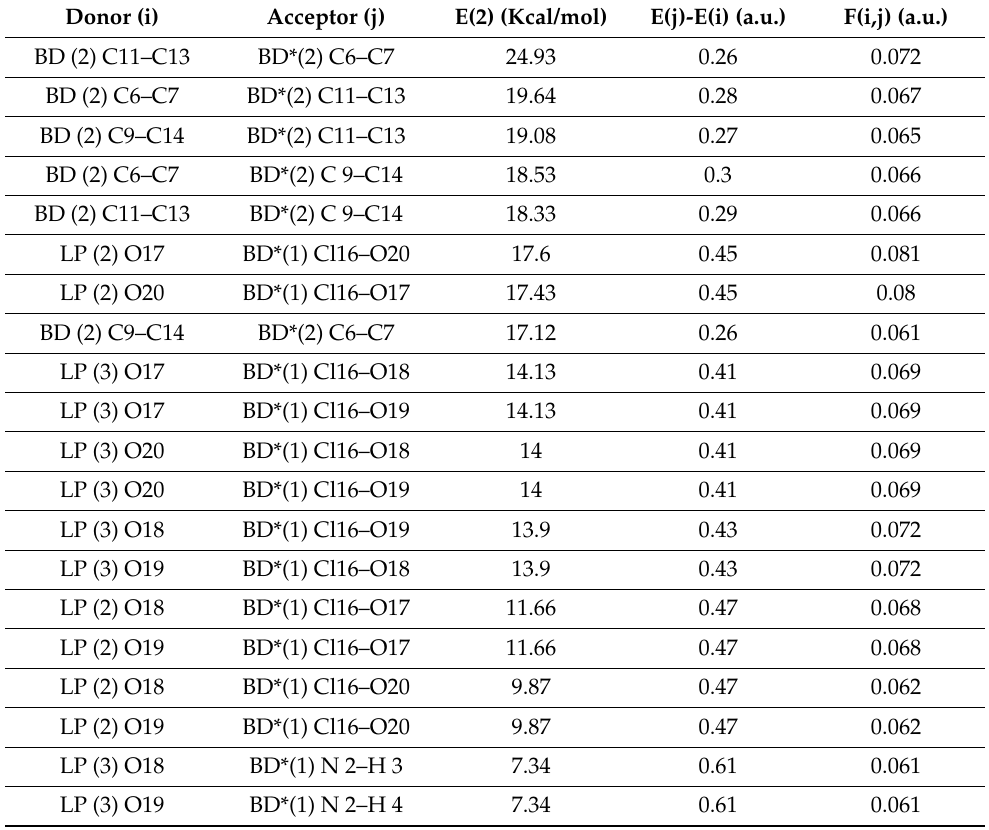
Table 4. The calculated results with the second-order perturbation theory of the Fock-matrix in NBO analysis of the 4BAP molecule, using the B3LYP